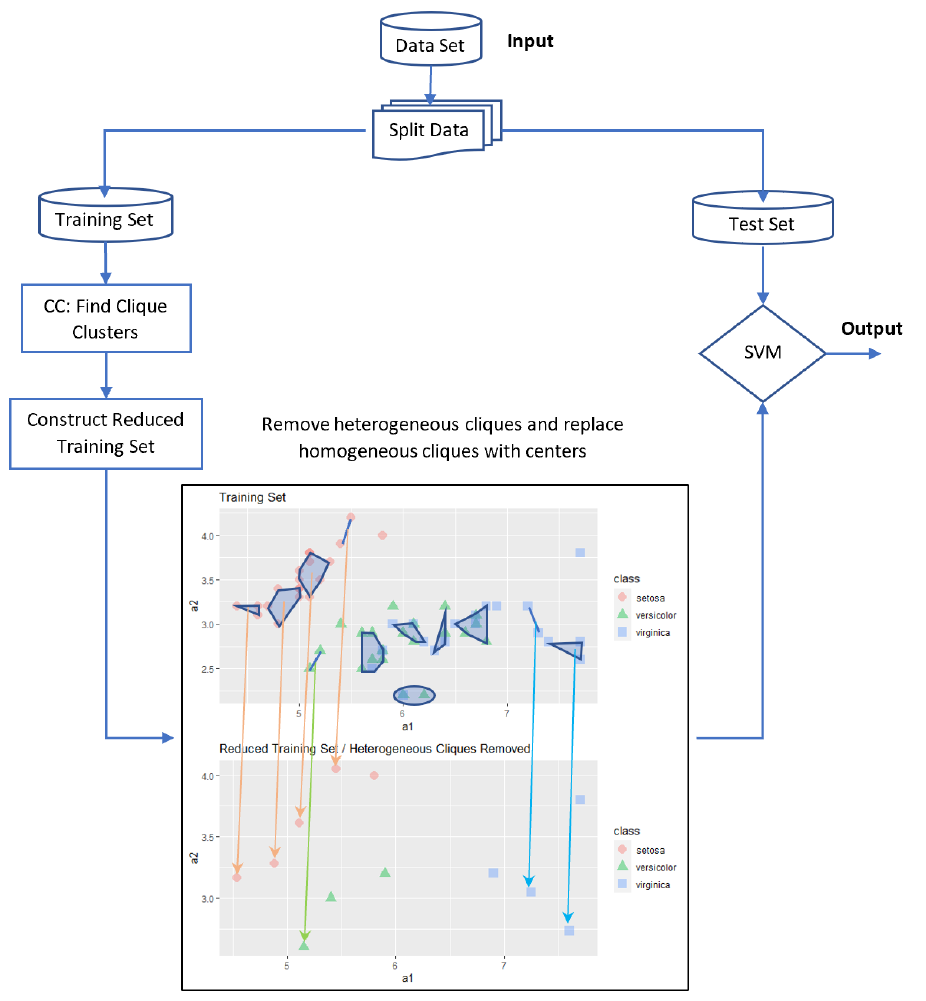
Figure 5. Flowchart of